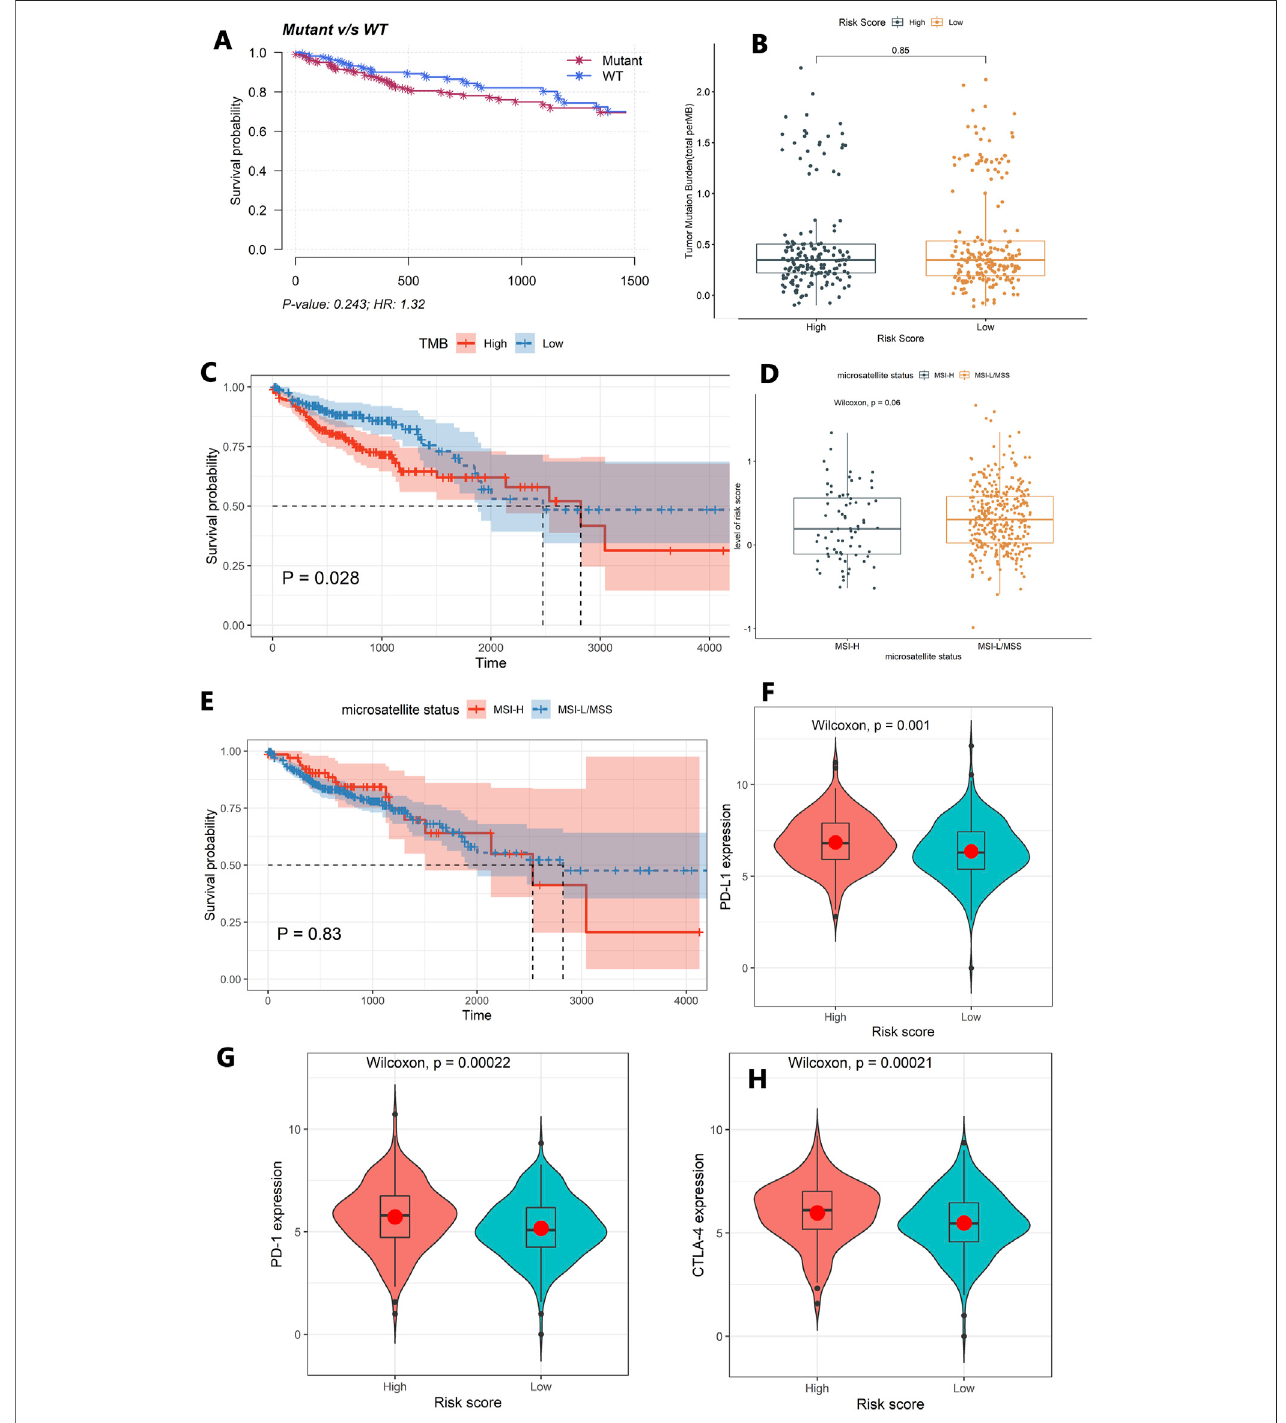
FIGURE 5 | Exploring the tumor immune microenvironment in colon cancer patients. (A) The association between the TP53 status and patients ’ OS. (B) The differenceofTMBbetweenthehigh-riskgroupandthelow-riskgroup. (C) TheassociationbetweenTMBandpatients ’ OS. (D) Thedifferenceintheleveloftheriskscore between the MSI-H and MSI-L/MSS groups. (E) The association between the microsatellite status and patients ’ OS. (F – H) Comparison of the expression levels of the immune checkpoints and their ligands between the high-risk score group and low-risk score group. (F) The expression of PD-L1, (G) the expression of PD-1, and (H) the expression of